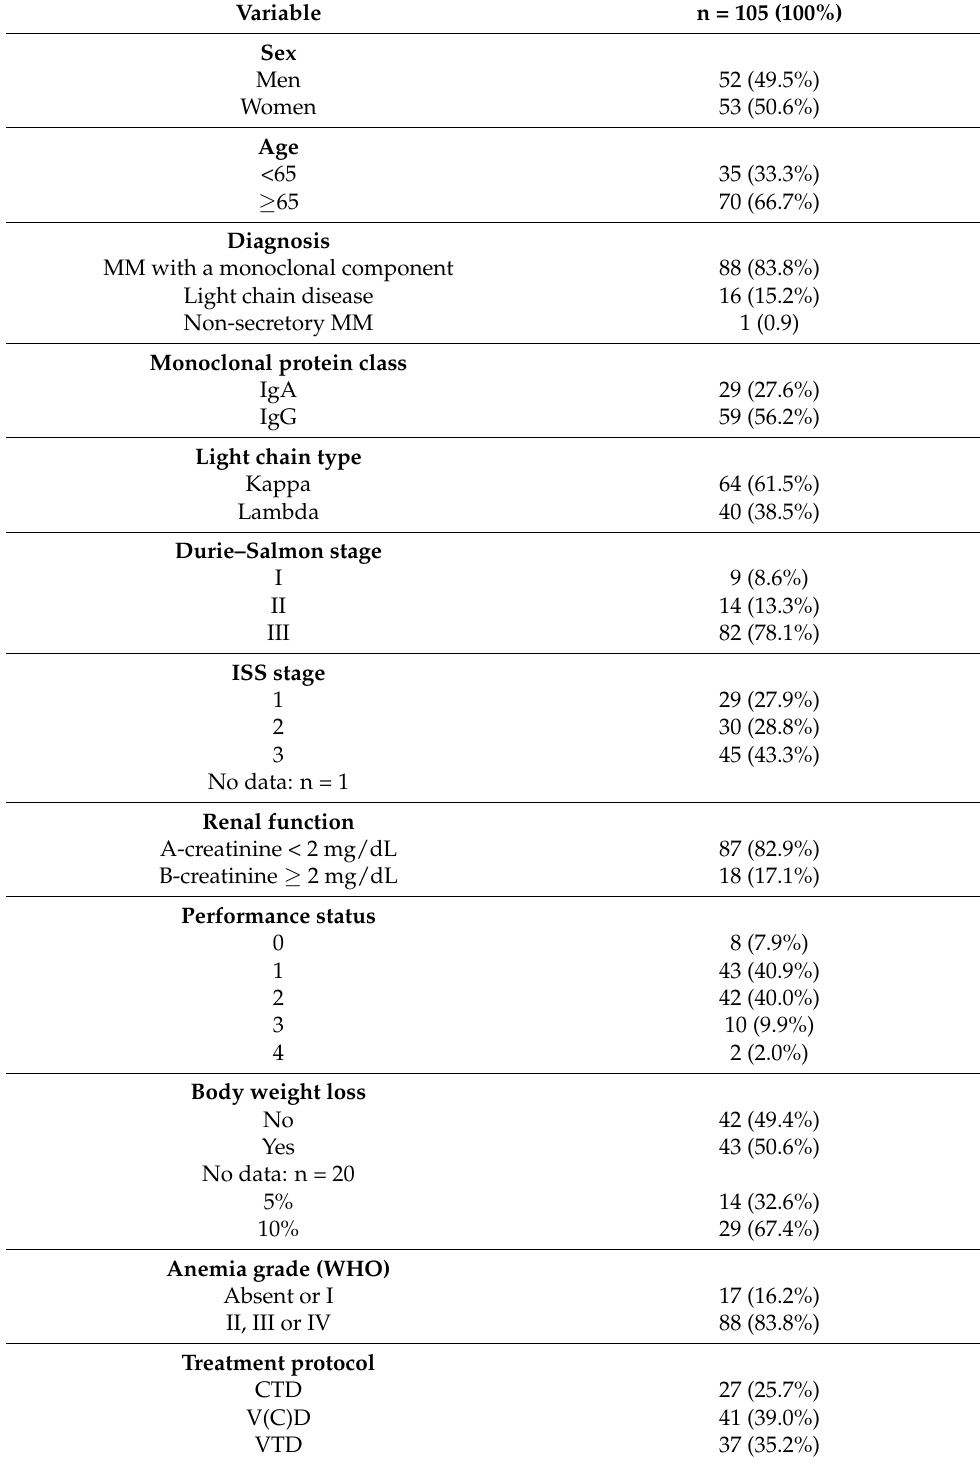
Table 1. Baseline characteristics of the study